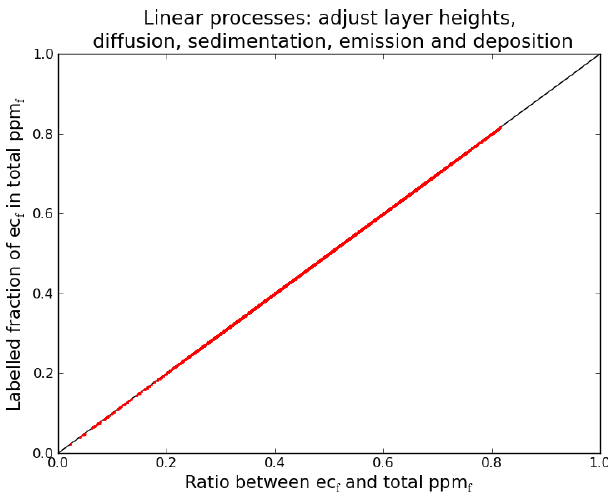
Fig. 1. Scatter plot of the ratio between fine elemental carbon (EC f) and total primary PM in the fine mode (PPM f) against the labelled fraction of EC f in PPM f. This scatter plot is valid for the linear processes: Adjust layer heights, vertical diffusion, sedimentation, emission and